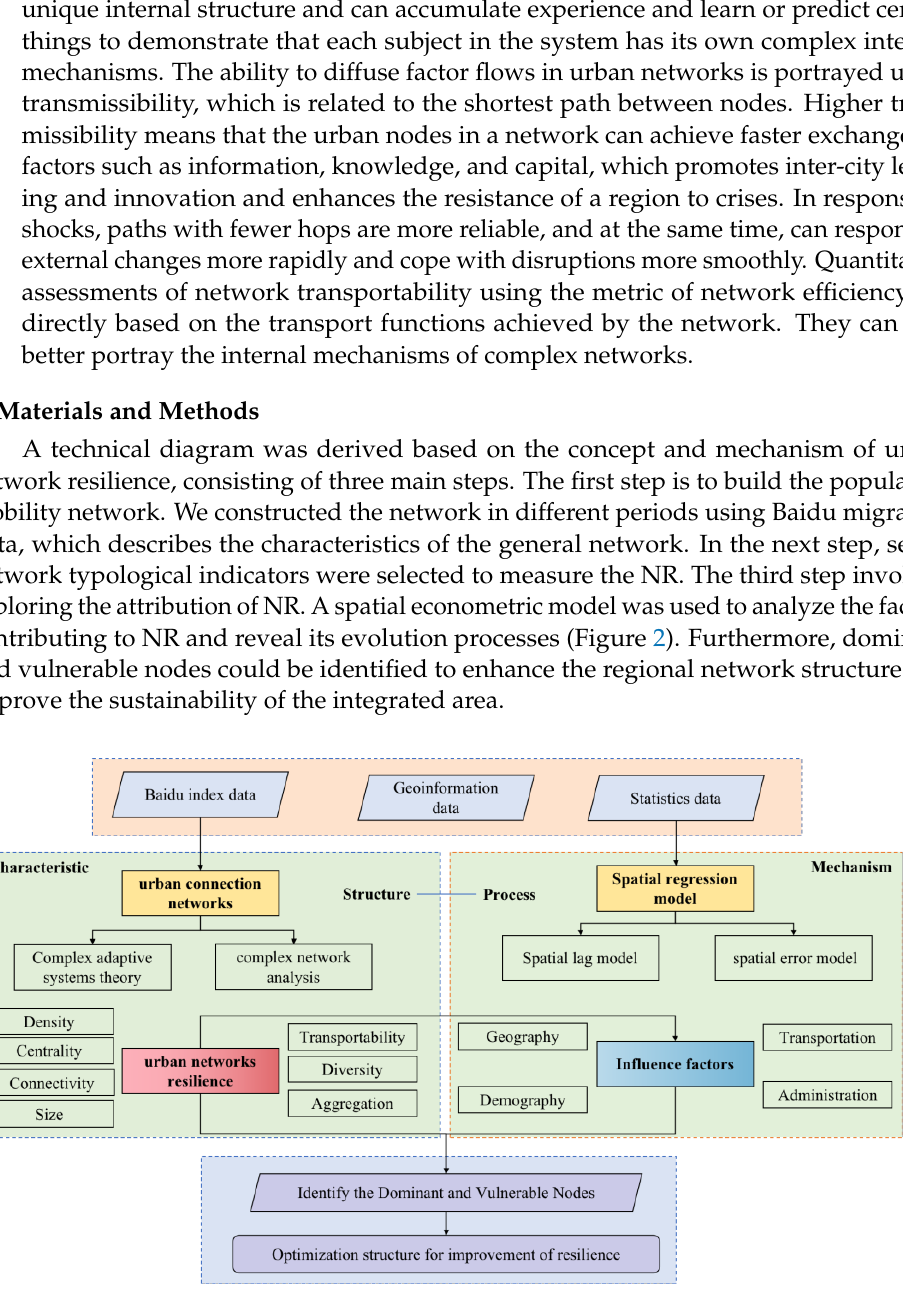
Figure 2. Integrated framework of network resilience for population